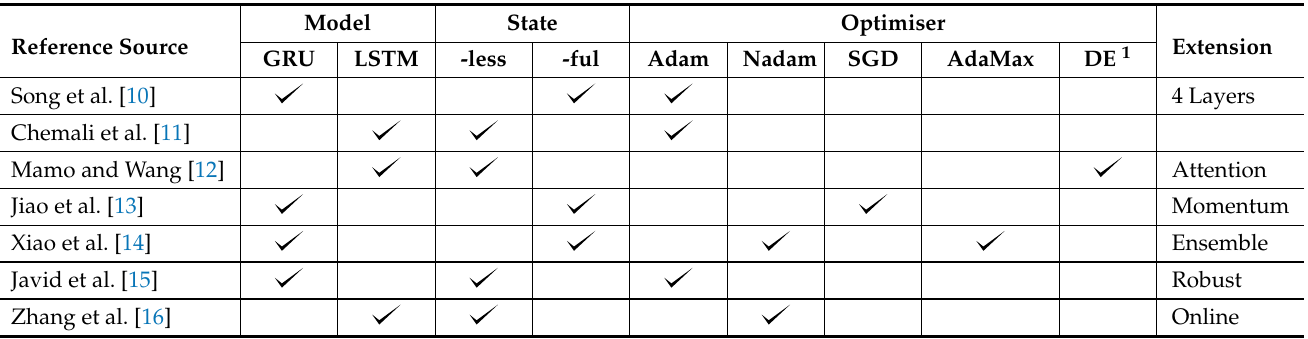
Table 1. Summary of evaluated papers’ implementation. The model type highlights a primary path to structuring a neural network. Statefulness defines the input method, whereas stateless models use a fixed size of input samples per feature and statefully apply each time-sample individually, in batches. Optimisers are defined using adaptive moment estimation (Adam), Nesterov adaptive moment estimation (Nadam), Stochastic gradient descent (SGD), AdaMax (AM) and Differential Evolution